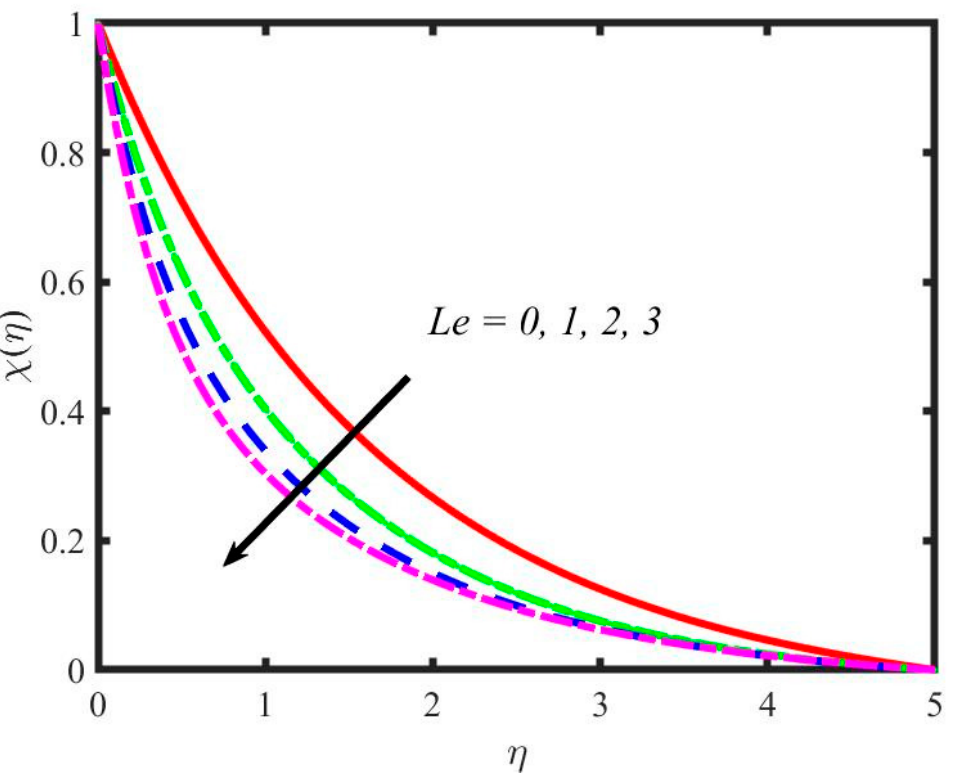
Figure 25. Variations in microorganism profile for Lewis number.